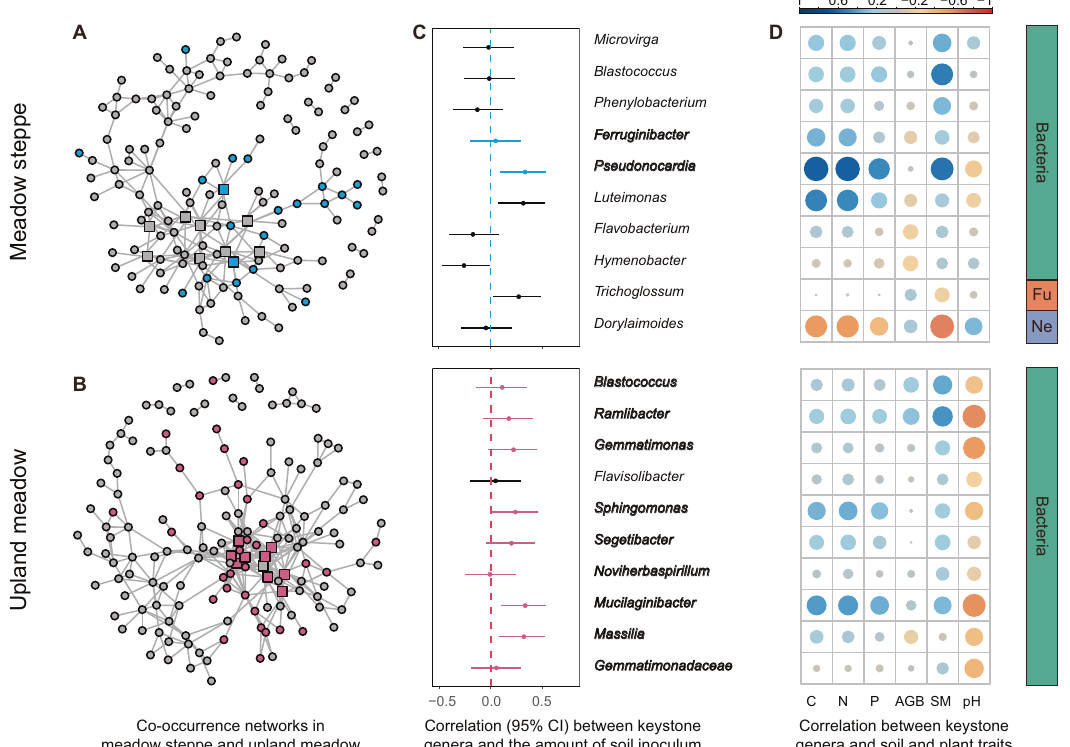
Fig. 6 Network analysis and increased genera after inoculation with different donor soils. Co-occurrence networks at genus level based on meadow steppe ( A ) and upland meadow ( B ) soil inoculation. Correlation between the relative abundance of 10 central genera with the highest node degree and soil inoculum amount ( C ) and soil and plant traits ( D ). Blue points (in A ) and pink points (in B ) indicated the genera signi fi cantly increased after inoculation meadow steppes and upland meadow soil than control plot. Square in networks (in A and B ) and bold genera names (in C ) indicated the genera signi fi cantly increased after soil inoculation. C: soil total carbon, N: soil total nitrogen, P: soil total phosphorus, AGB: aboveground biomass, SM: soil moisture, Ne: nematodes, Fu,